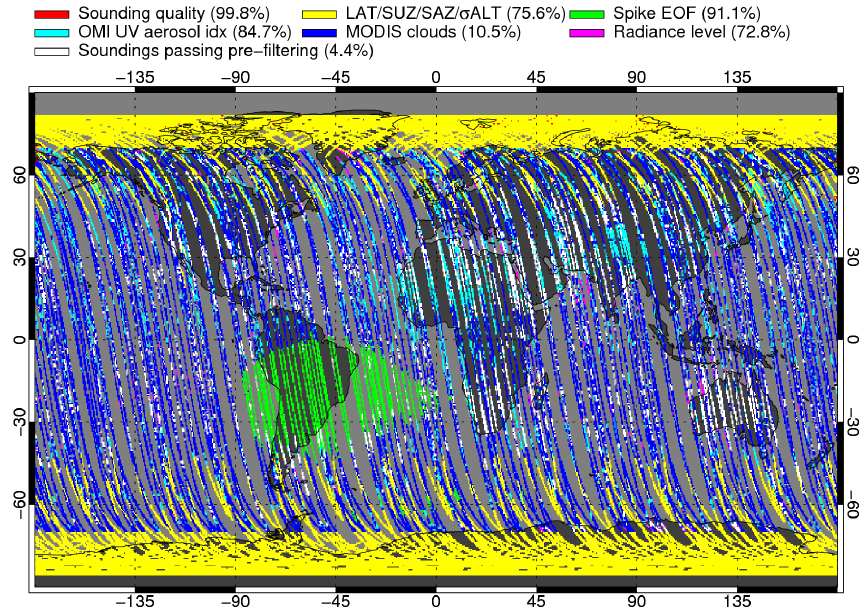
Figure 2. Pre-filtering statistics of the 24 days data subset used for the noise model analysis (Section 3.1). The filters are applied in the order: Sounding quality, LAT/SUZ/SAZ/ σ ALT, Spike EOF, OMI UV aerosol idx, MODIS clouds, and Radiance level (see main text for a description). The colors represent filter activity and soundings passing all filters are shown in white. Numbers in brackets represent filter